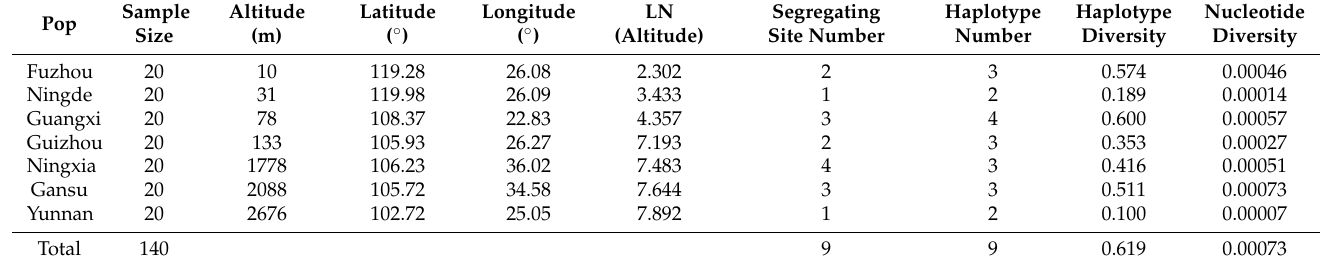
Table 1. Sample size, geographic origin, and genetic diversity of RAD23 in the seven Phytophthora infestans populations from China.